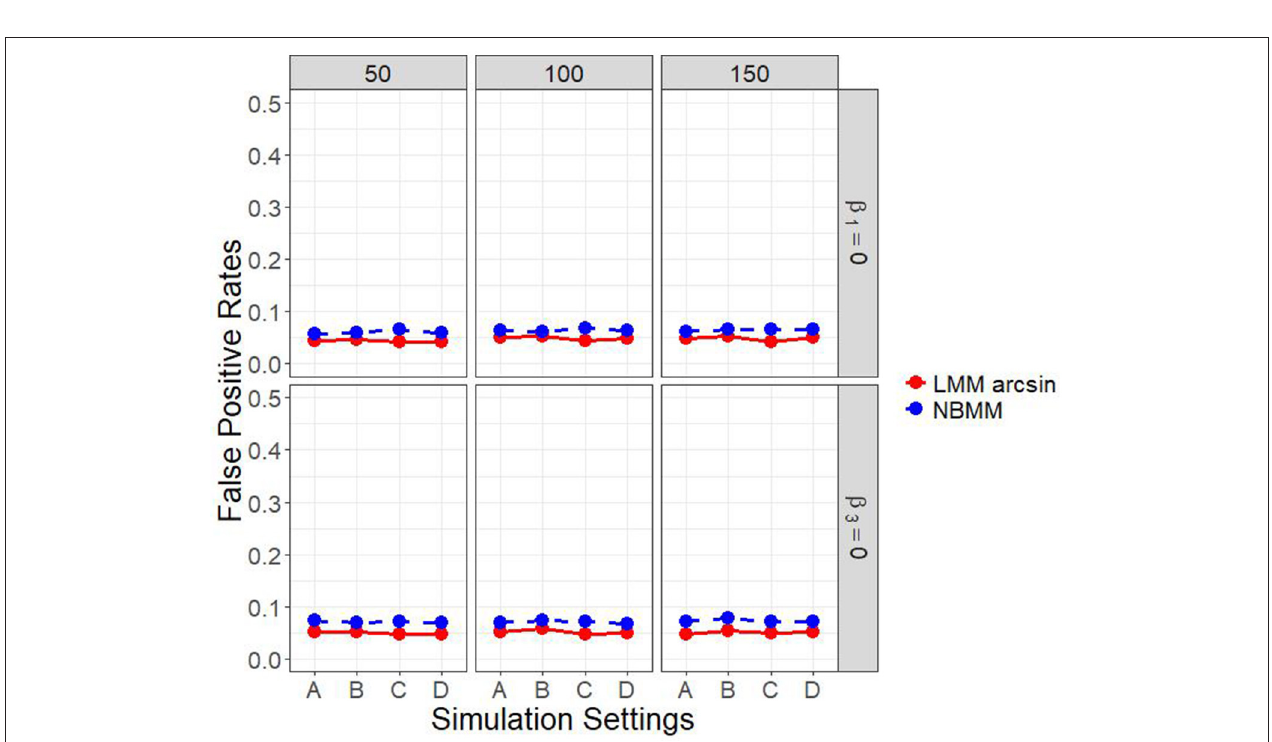
FIGURE 3 | False positive rates of both interaction term and main effect in all four simulation settings.